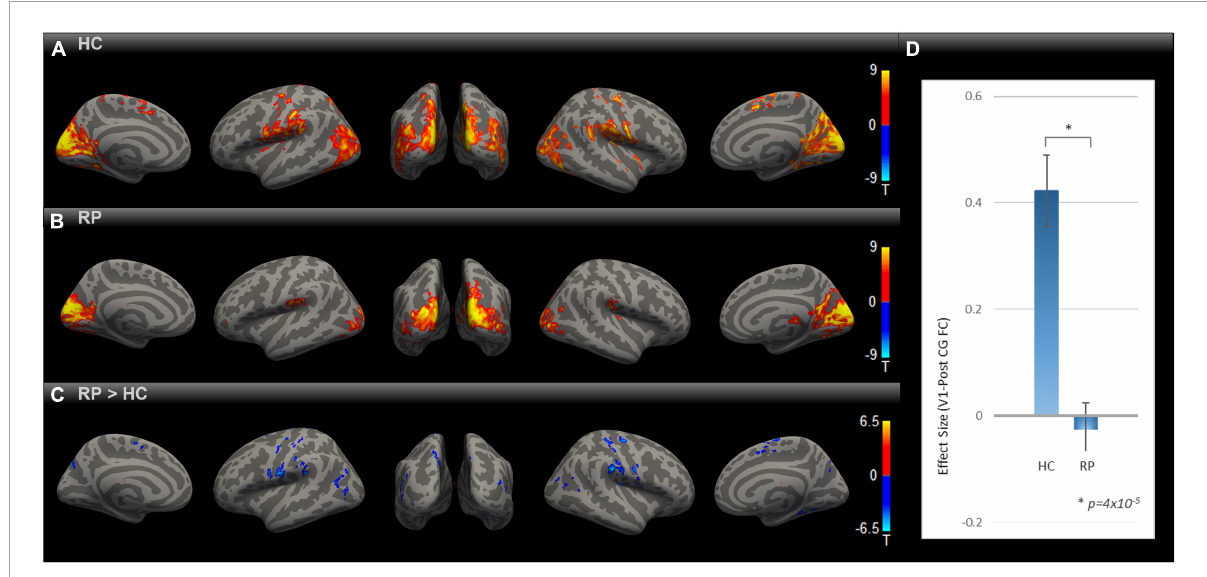
FIGURE1 Comparing rsFC between RP and HC. Group-level rsFC maps using V1 as the seed for HC (A) , RP (B), and RP > HC contrast (C) were corrected for multiple comparisons using Gaussian Random Field Theory with an uncorrected voxel-level threshold of p < 0.001 and a cluster-level threshold of p < 0.05 FDR corrected for cluster size. Areas with lower rsFC to V1 covered regions of higher-level visual, primary/secondary somatosensory, motor, and parietal association cortex [blue blobs in (C) ]. V1-to-PostCG ROI analysis (D) showed significantly lower rsFC effect size in RP vs. HC, using two-sample t -test [ t (18) = –5.39, * p = 4 × 10 − 5